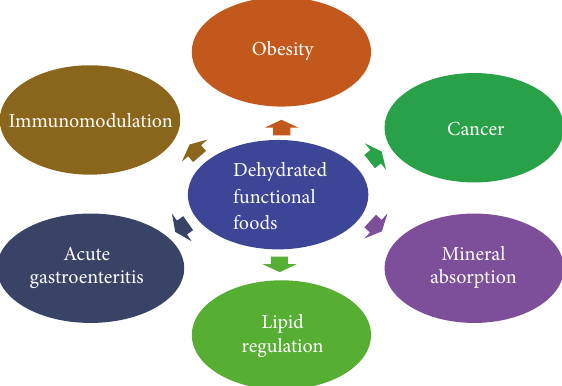
Figure 2: Health benefits of dehydrated functional foods